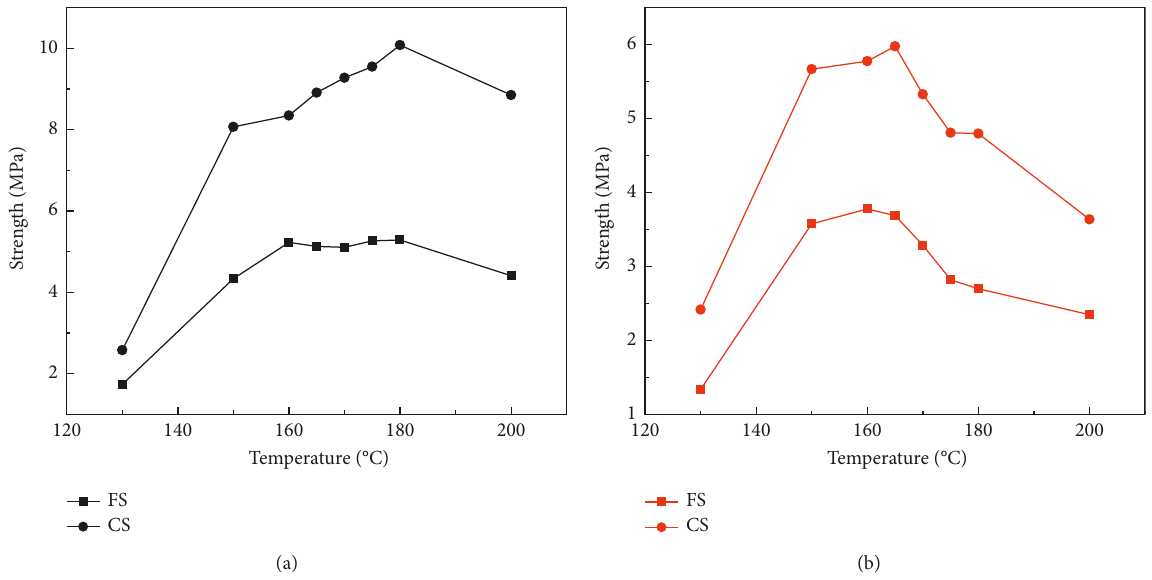
Figure 2: Effect of preparation temperatures on the strength of POP and